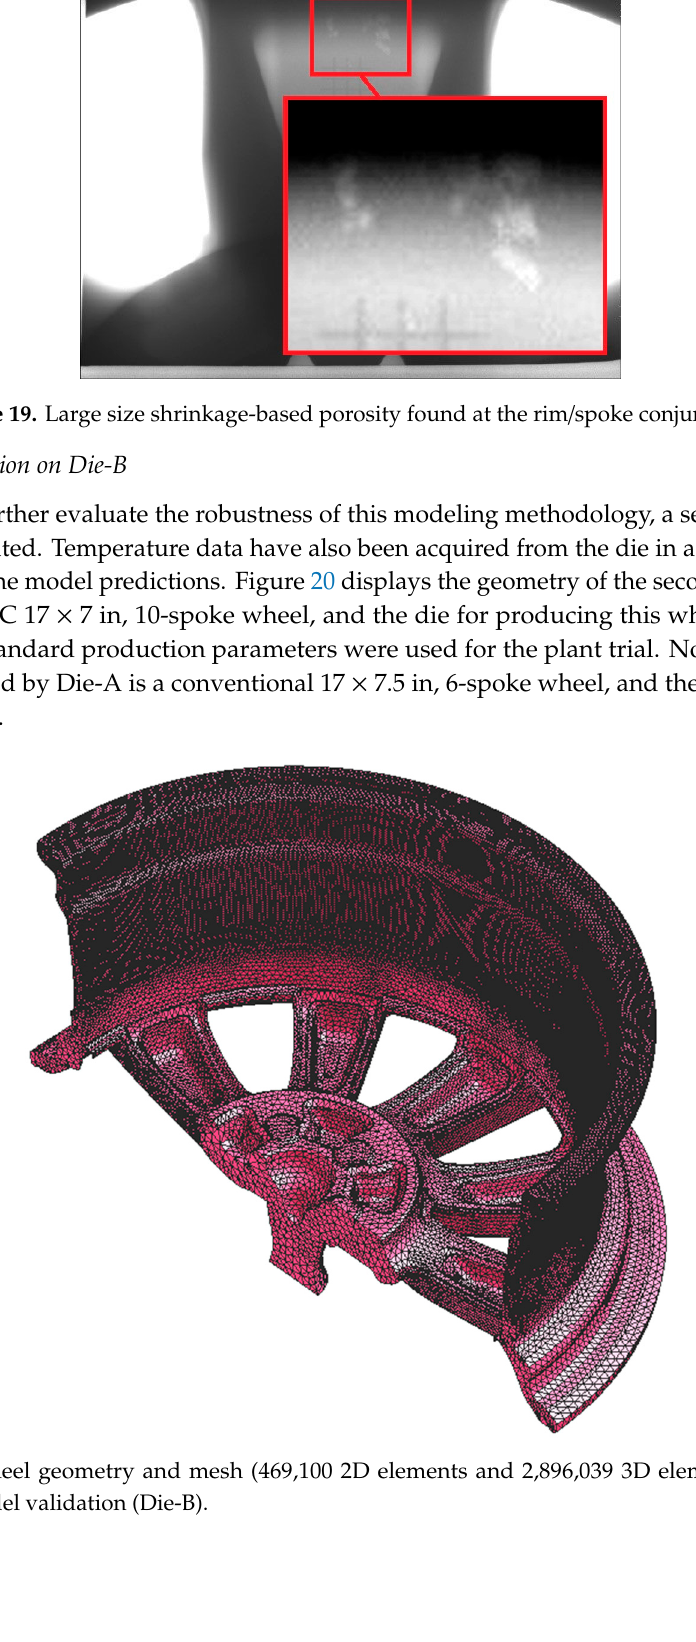
Figure 18. Solidification path for the non-production process condition.